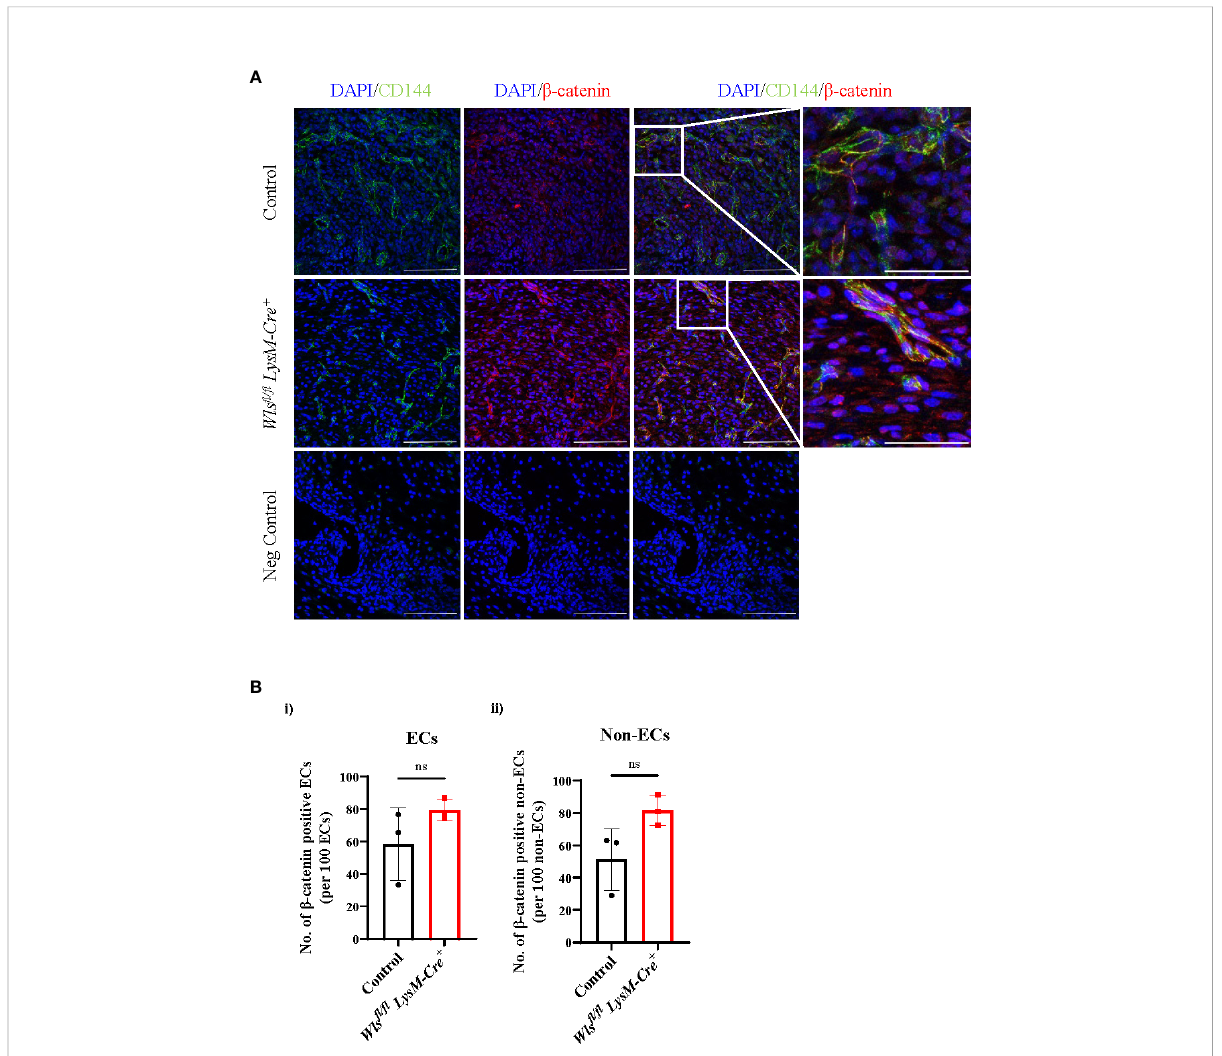
FIGURE 5 Nuclear b -catenin number in the Wls fl / fl LysM-Cre + mice remain unchanged in the wound endothelial cells. (A) Representative immuno fl uorescence staining of the b -catenin (red), CD144 (green) and DAPI (blue) in the day 5 Wls fl / fl LysM-Cre + and Wls fl / fl LysM-Cre neg wounds (scale bar = 100µm). White boxes highlighted CD144 + endothelial cells co-localized with nuclear b -catenin + imaged at higher magni fi cation (scale bar = 100µm). (B) Quanti fi cation of the b -catenin in the (i) ECs and (ii) non-ECs showed no difference in the number of nuclear b -catenin between the Wls fl / fl LysM-Cre + and control mice. Data are represented as mean ± SD. Statistical analysis was performed using unpaired Student t-tests. ns = not signi fi cant, ECs = endothelial cells. Data are representative of 3 individual animal